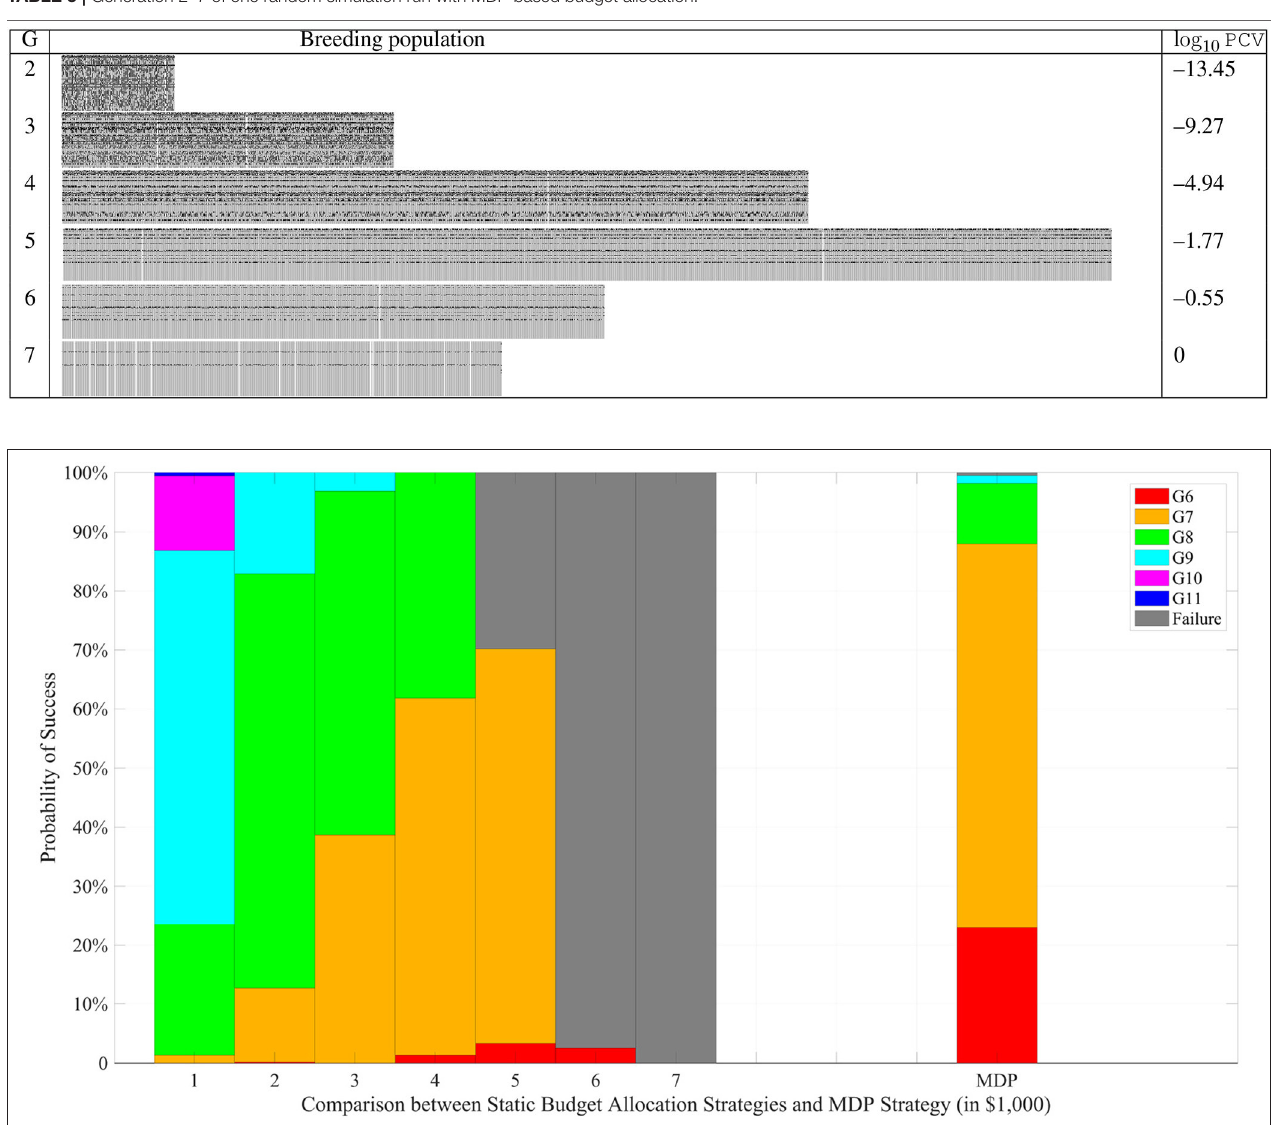
FIGURE 4 | Comparison under a fixed total budget of $32,000. The left 7 stacked bars represent the static budget allocation strategies with different progeny number per generation while the last bar represents the MDP based strategy.